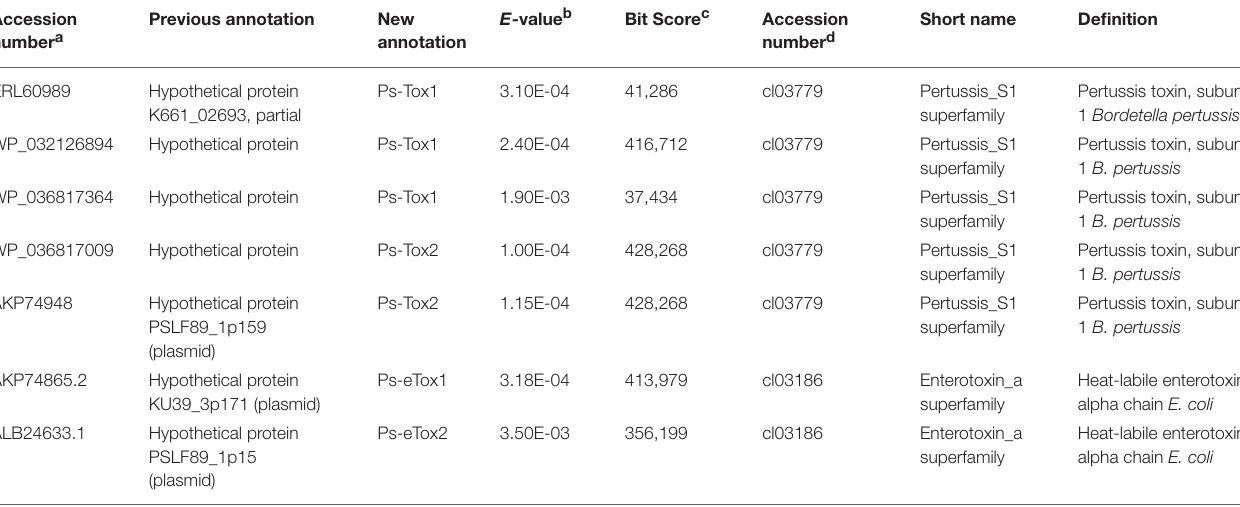
TABLE 4 | Toxins identified by MudPIT analysis from Piscirickettsia salmonis LF-89 type strain membrane